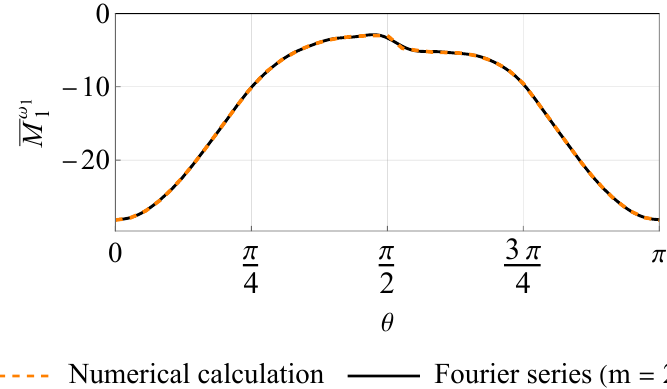
Figure 4. Coefficient ¯ M ω 1